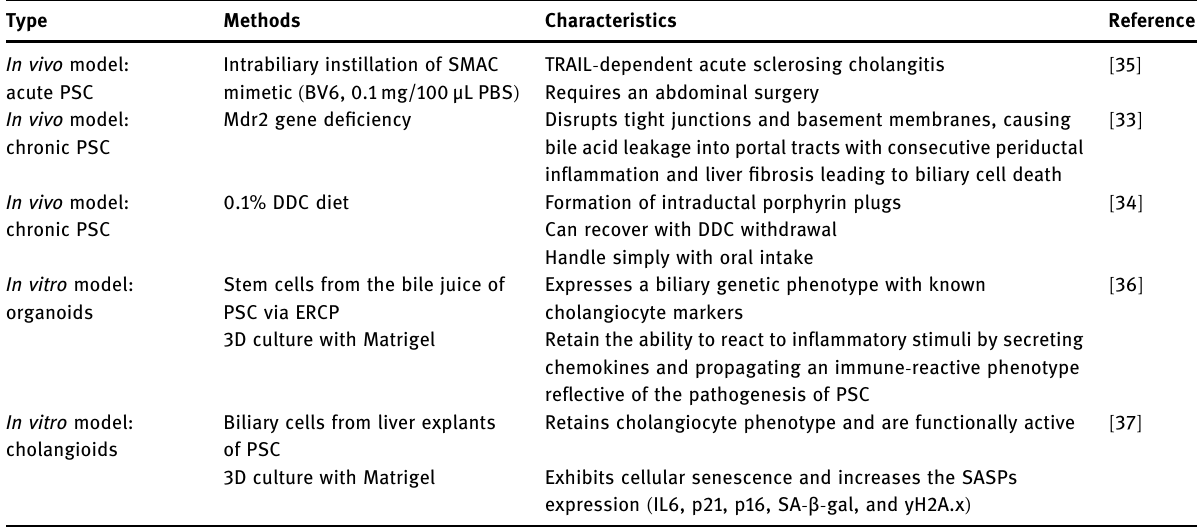
Table 3: Commonly used models for studying the PSC Type Methods